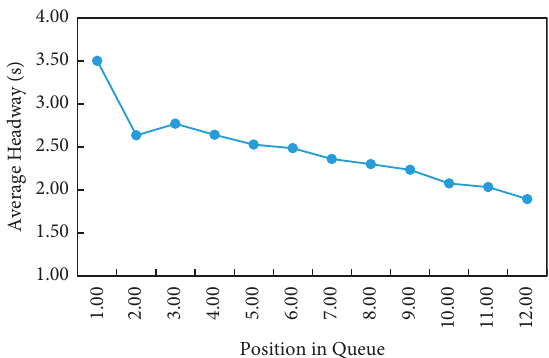
Figure 17: The simulation value of headways in 0% heavy vehicles scenario.